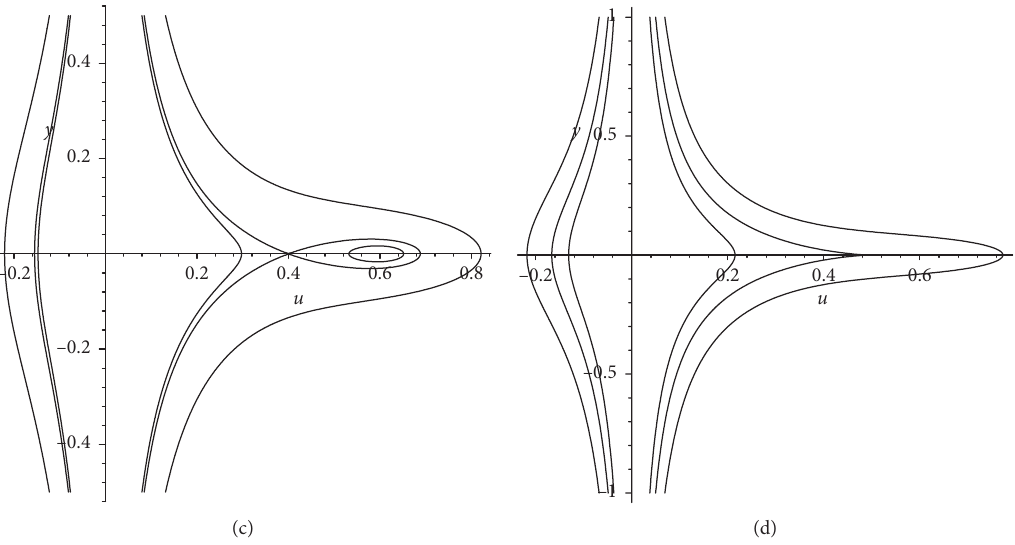
Figure 4: Phase portraits of system (9) when c < − 1. (a) g < 0. (b) g � 0. (c) g